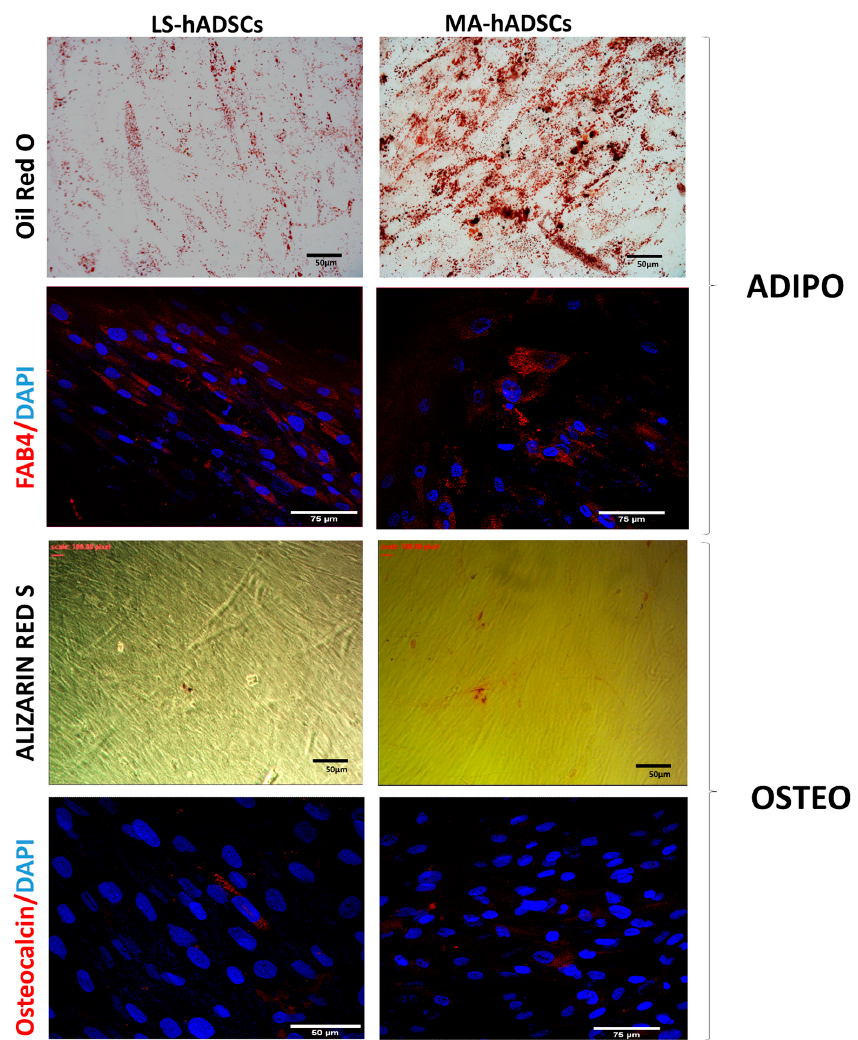
Figure 4. hADSC in vitro differentiation. Cells obtained from lipoaspirated adipose tissue mechanically activated (MA-hADSCs) or not (LS) were differentiated in vitro (as described in the Materials and Methods section). Adipogenesis was revealed by Oil red O staining for lipid droplets and with the positivity to the adipogenic marker FABP4 evidenced with immunofluorescence. FABP4 is shown in red and nuclei in blue (DAPI). Osteogenic differentiation was marked by the formation of mineralized matrices as shown by Alizarin red staining and osteocalcin expression by immunostaining. Osteocalcin is shown in red and nuclei in blue (DAPI). Data are representative of two different experiments for four cases for MA-hADSCs and two cases for